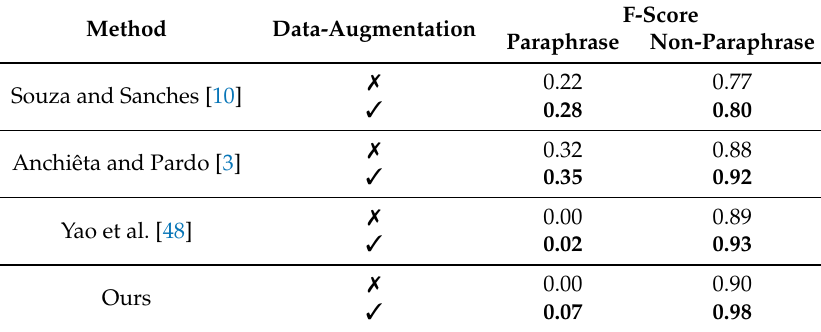
Table 9. Comparison among approaches on the ASSIN